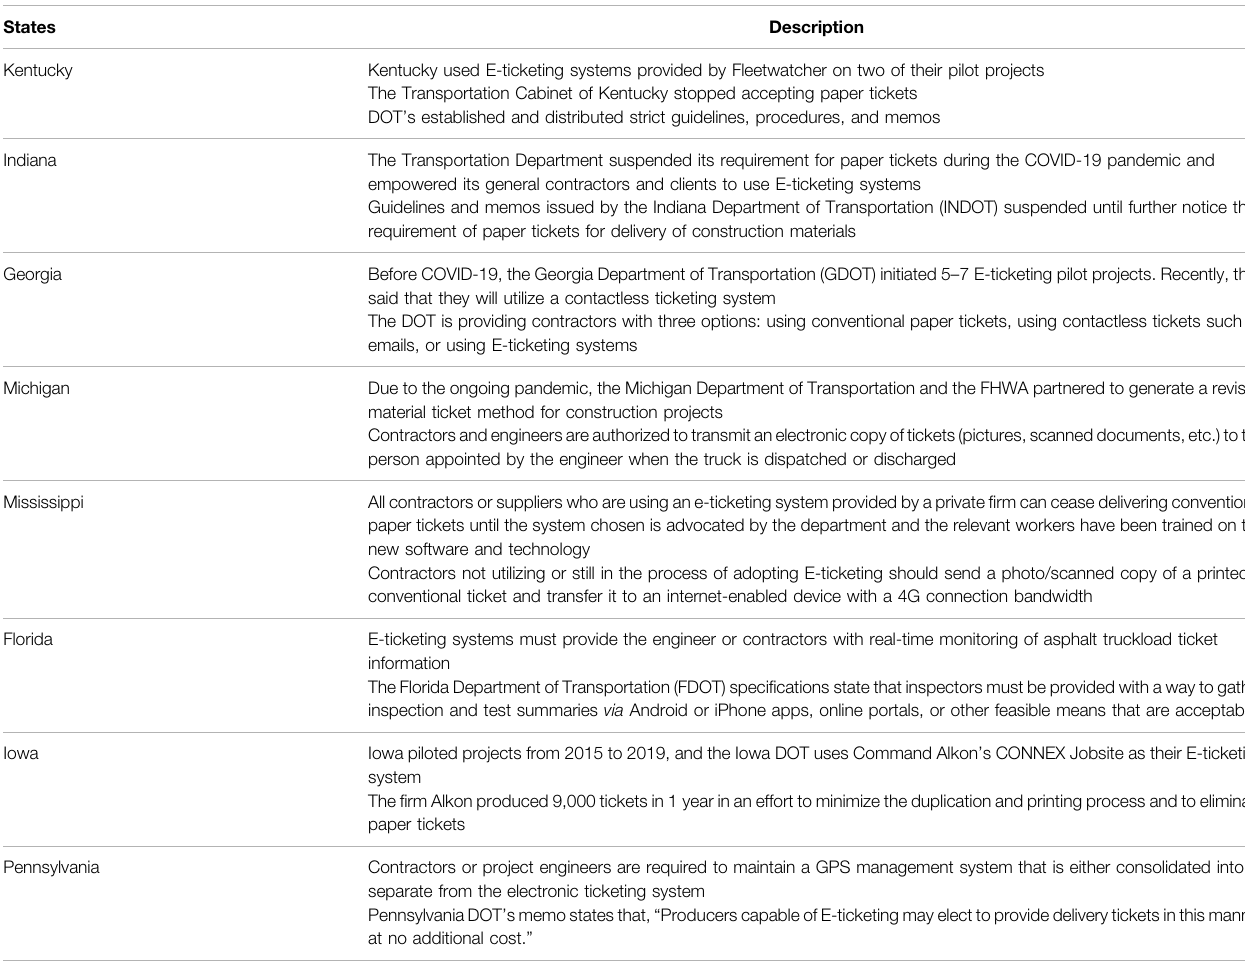
TABLE 7 | State-wide implementation of guidelines and policies. States